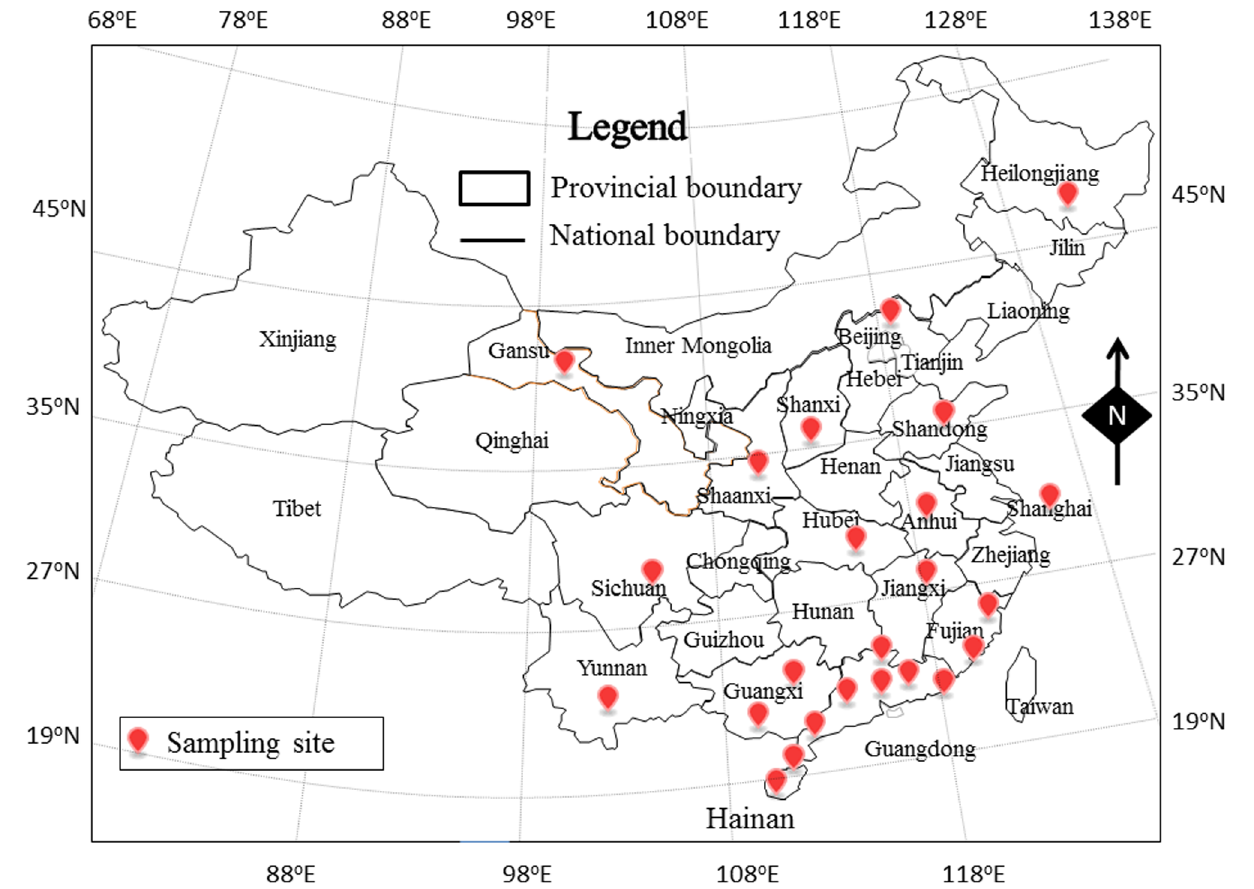
Fig 1. The locations of the sampling sites for this study in China. Based on 30° northern latitude, there are six cities in north China and 18 cities in South